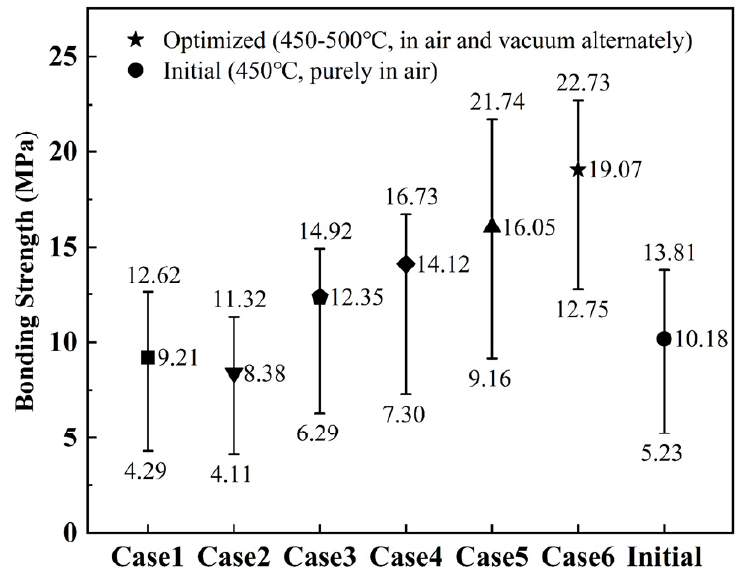
Figure 5. The effect on bonding strength of different thermal conditioning process.( Case1 , Case2 ) Annealing in air and under vacuum at 400 °C for 60 min, respectively; ( Case3 ) Annealing in air at 450 °C for 30 min and annealing under vacuum at 450 °C for 30 min; ( Case4 , Case5 ) Annealing in air at 450 °C for 30 min and annealing under vacuum at 450 °C for 30 min and annealing in air at 450 °C for 30 min and for 60 min, respectively; ( Case6 ) Annealing in air at 450 °C for 30 min and annealing under vacuum at 450 °C for 30 min and annealing in air at 500 °C for 60 min; (initial) Annealing in air at 450 °C for 30 min. Table 3. The leak rate of initial and optimized bonded pairs.